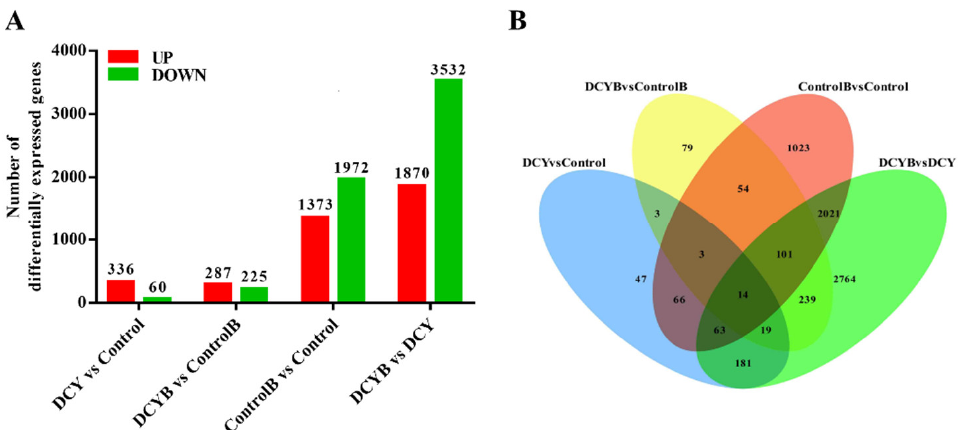
Figure 4. DEGs induced in rice plants by DCY and BPH infestation: ( A ) Comparison of upregulated and downregulated DEGs, and ( B ) Venn diagram of DEGs.